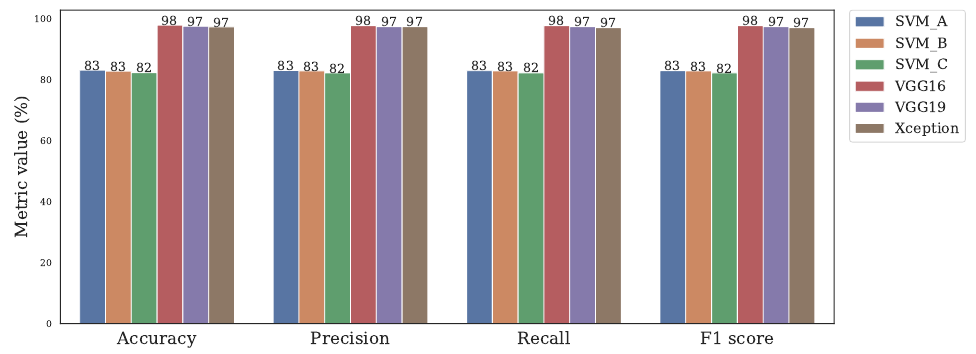
Figure 12. Comparison of classification